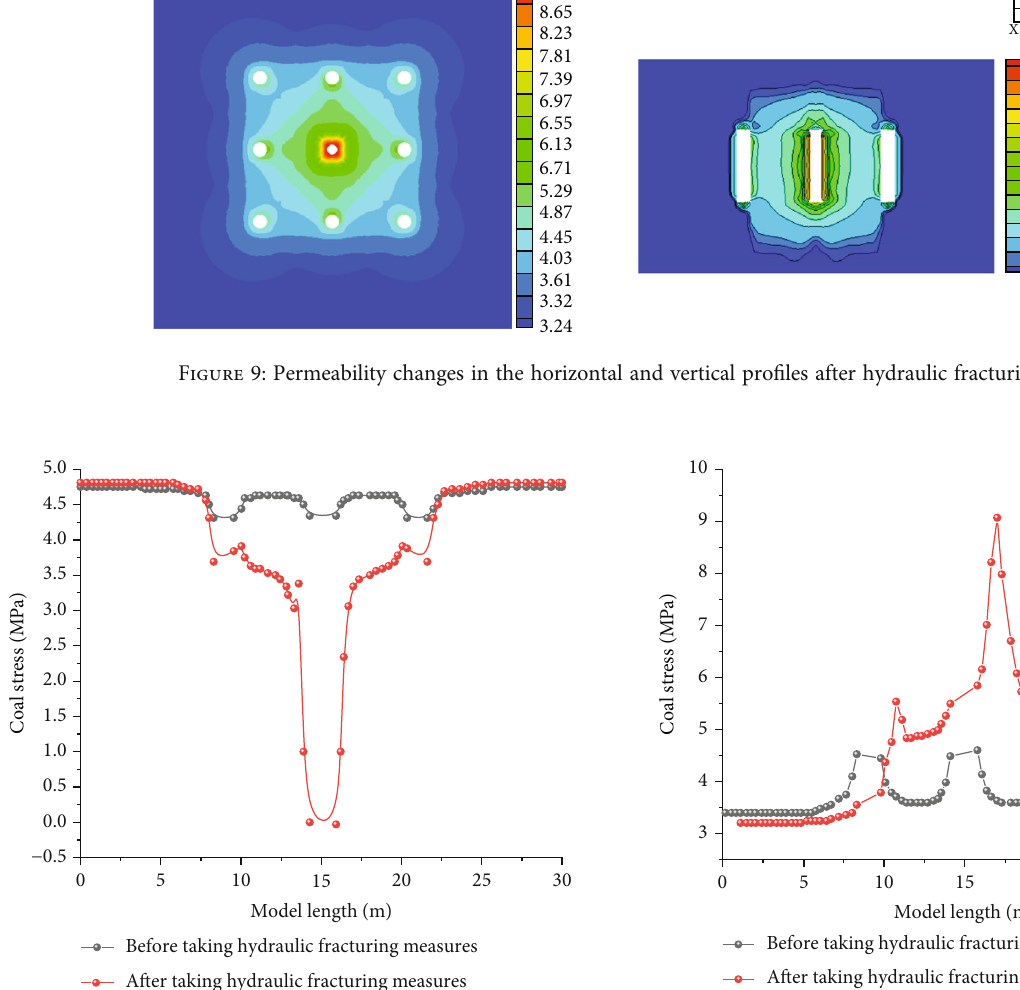
Figure 10: Curves of coal stress changes before and after implementing hydraulic fracturing measures.